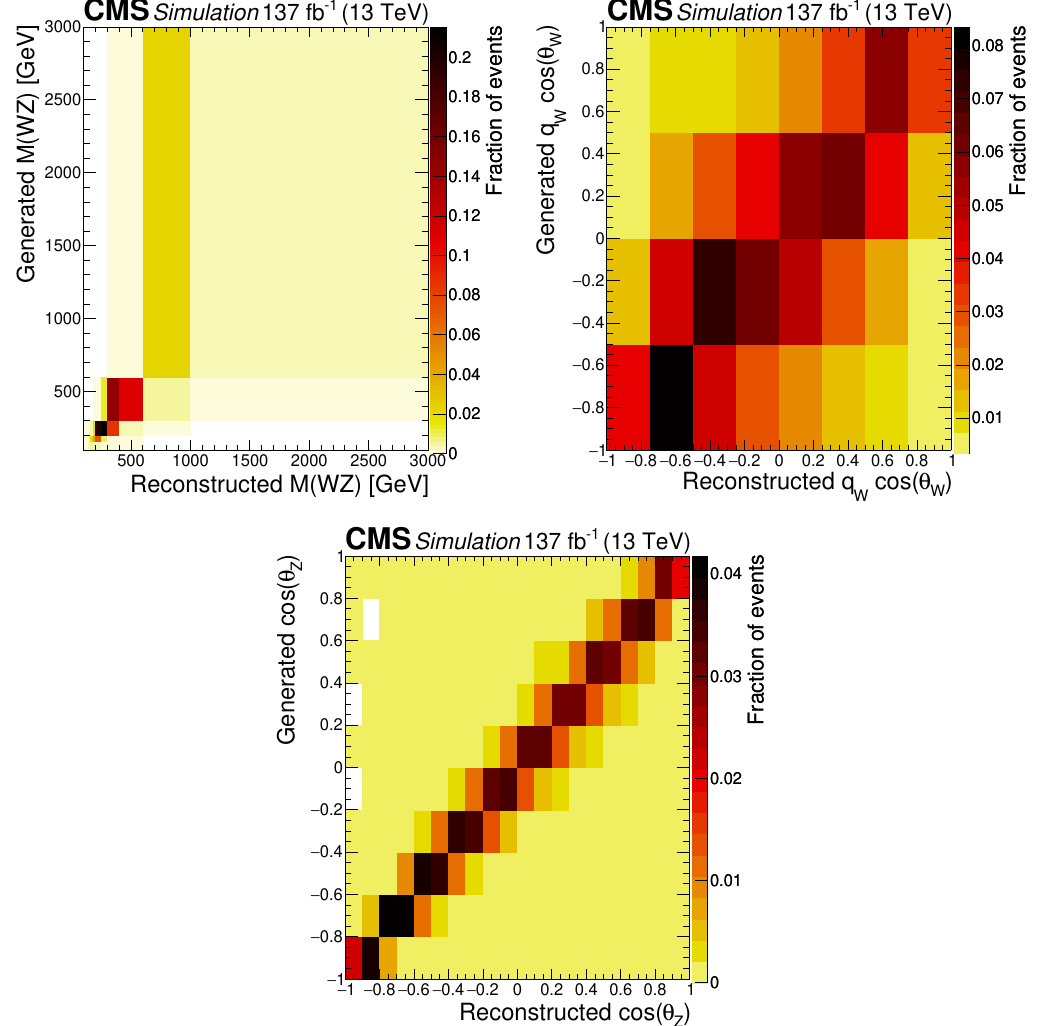
Figure 13 . Response matrices obtained at NLO in QCD using the powheg generator. Invariant mass of the WZ system M (WZ) (top left, condition number 64.0), cosine of the polarization angle (top right, condition number 7.84), and cosine of the polarization angle θ θ W number